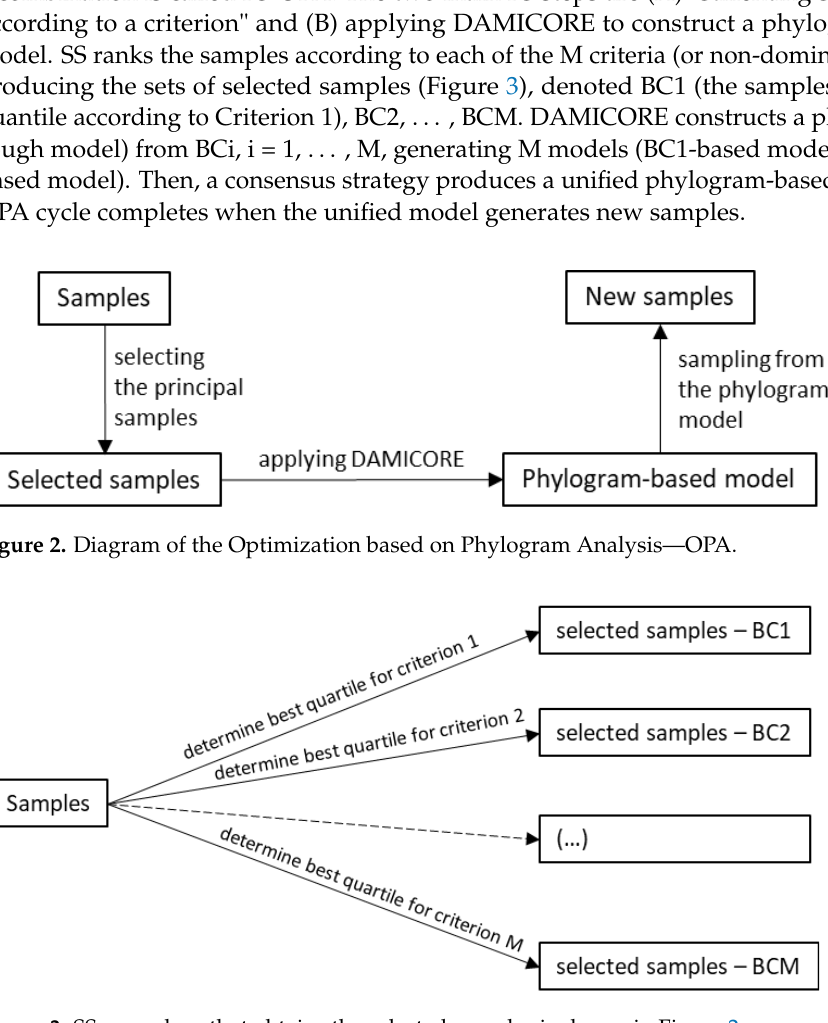
Figure 3. SS procedure that obtains the selected samples is shown in Figure 2.